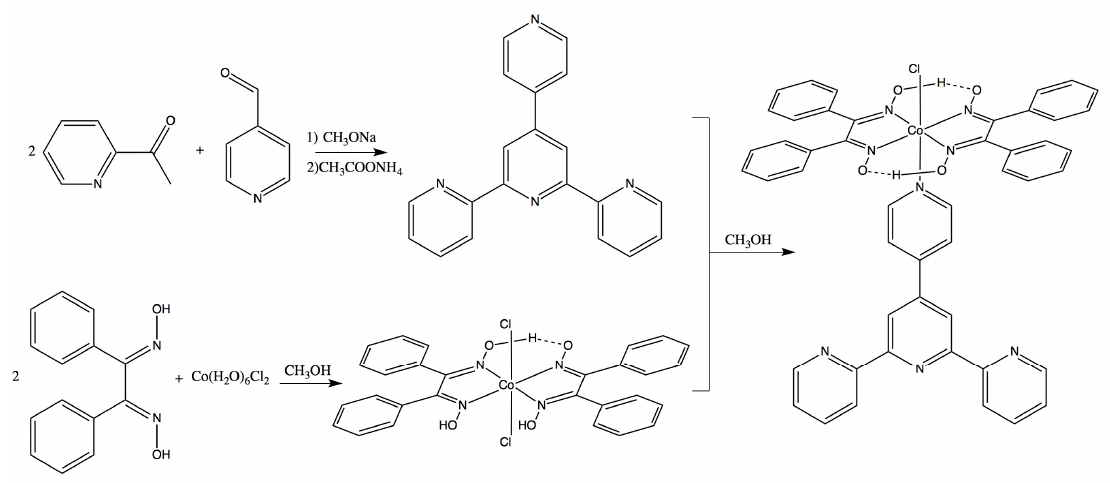
Figure 1. Synthetic route to prepare the [CoCl(dpgH) 2 (pytpy)] complex.